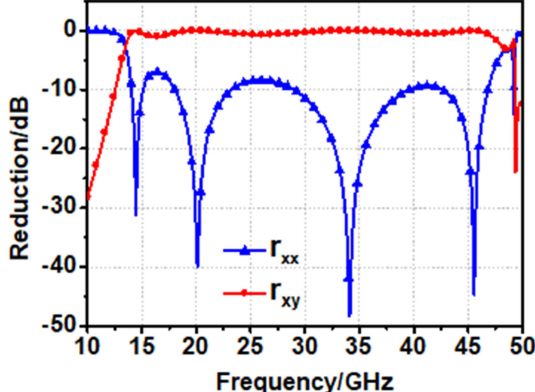
Figure 3. Simulation results of reflected wave of unit under normal x -and y -polarization incident